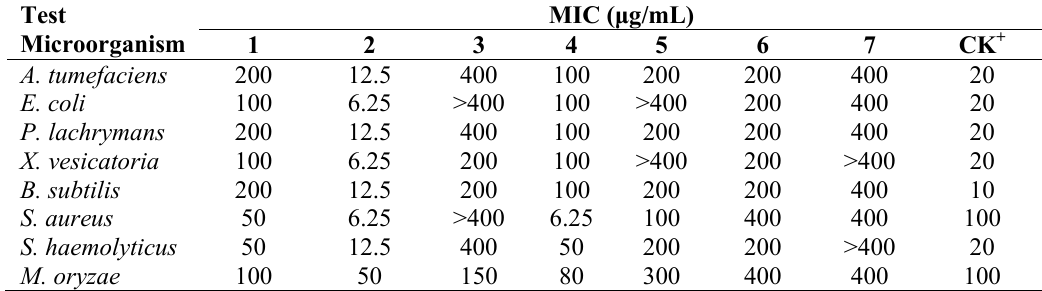
Table 1. MIC values of the flavonoids from H. caspica on microorganisms. Test